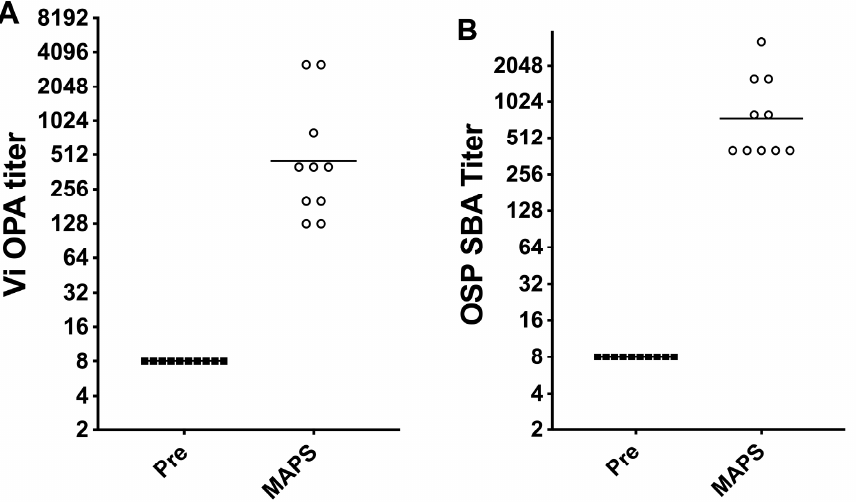
Figure 7. OPA titers of anti-Vi antibodies ( A ) and BCA titers of anti-OSP antibodies ( B ). Rabbits were immunized with the bivalent vaccine twice, and sera were taken two weeks after the last immunization.